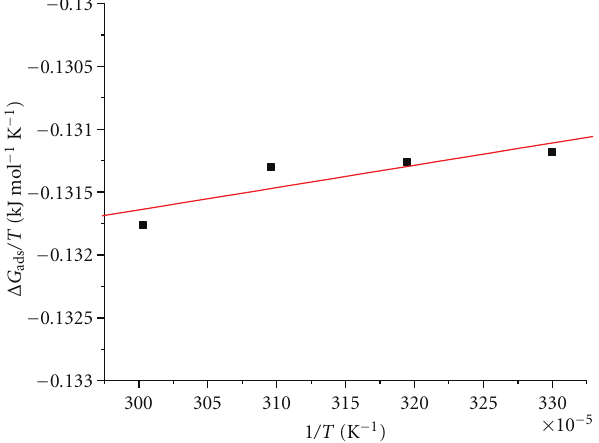
/T versus 1 /T plot for mild steel in 1M HCl solu-